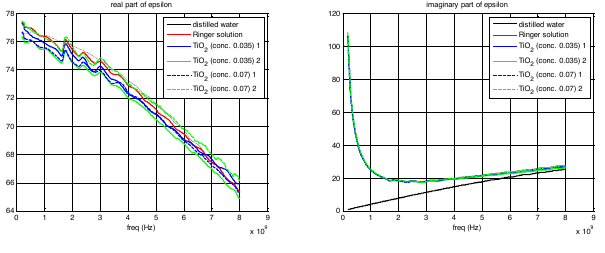
Figure 8: Variation of the real ( left ) and imaginary ( right ) part of the complex dielectric constant in the range from 100 MHz to 8 GHz for different